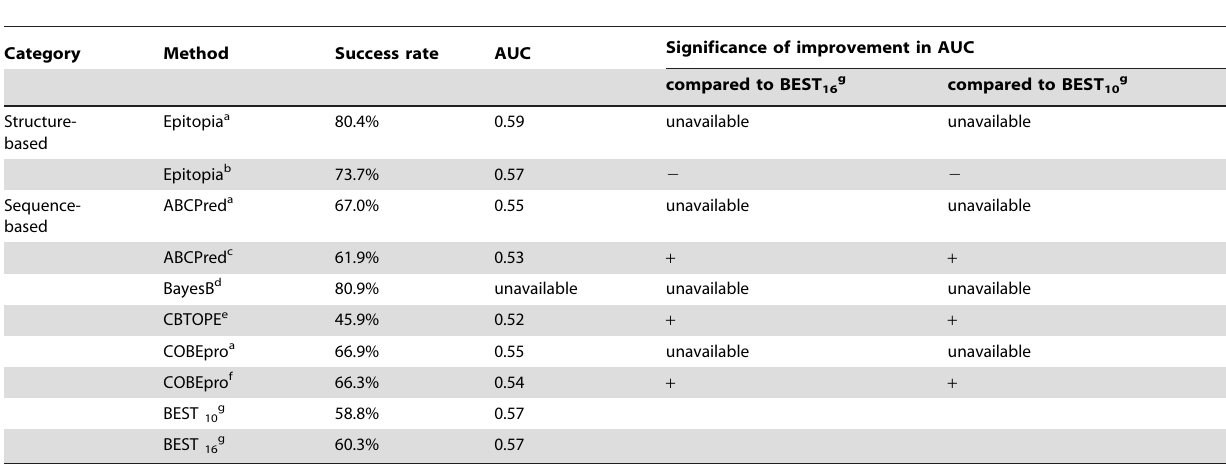
Table 6. Comparison of the proposed BEST method with existing B-cell epitope predictors on the SEQ149 dataset.